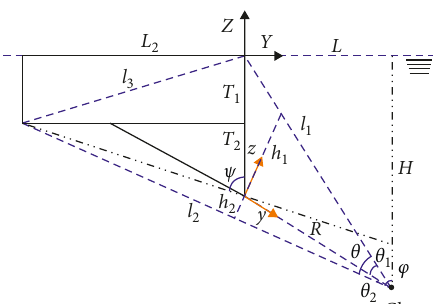
Figure 4: Side view of charge at S